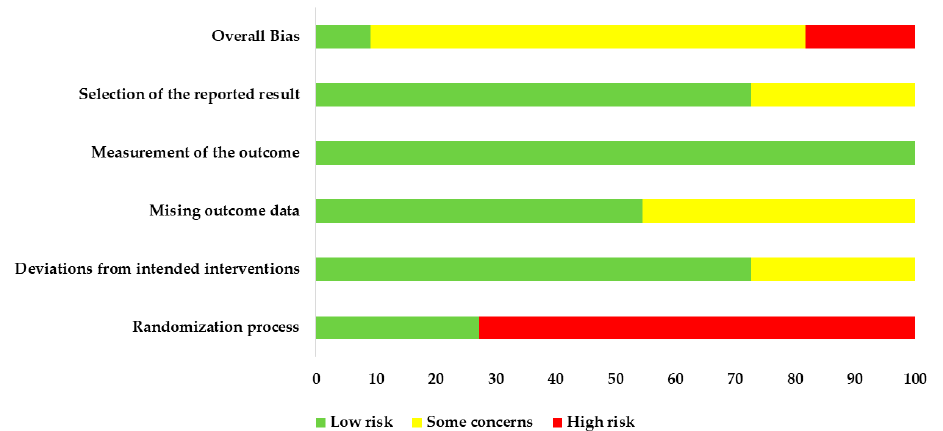
Figure 7. Risk of bias graph. Judgments about each risk of bias item were presented as percentages across all included studies.